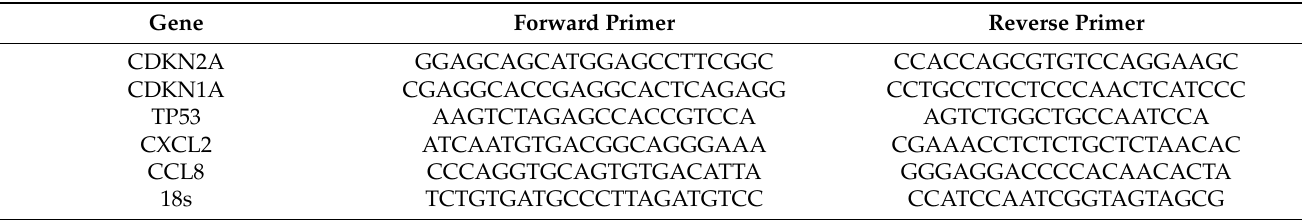
Table 1. Oligonucleotides used for real-time